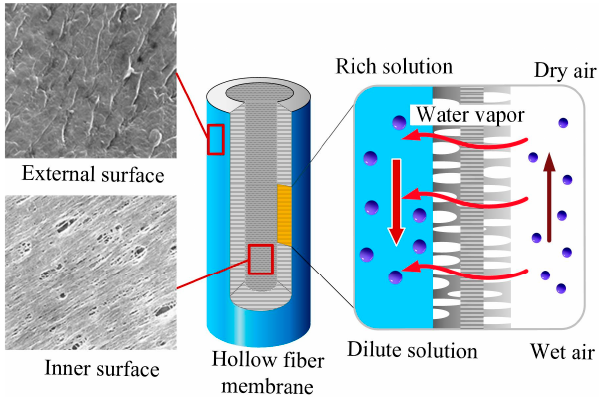
Figure 1. A schematic diagram of water separation.